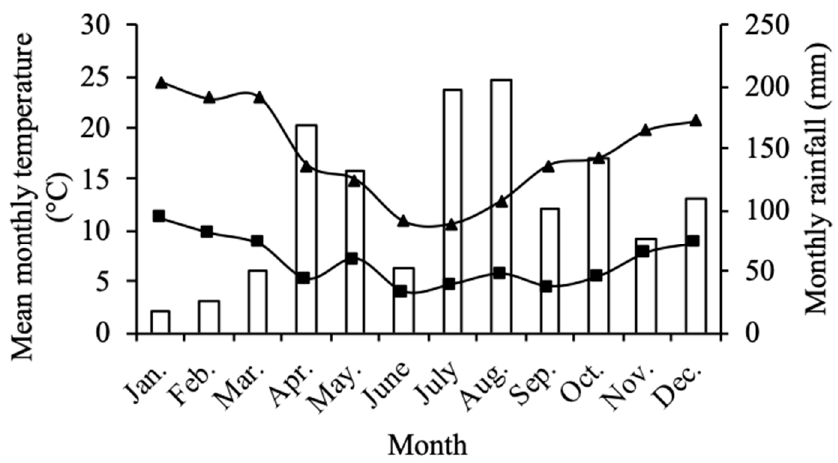
Figure 1. Mean monthly maximum ( ▲ ) and minimum ( ■ ) temperature and monthly rainfall ( □ ) for Valdivia, Chile, from January to December 2016.